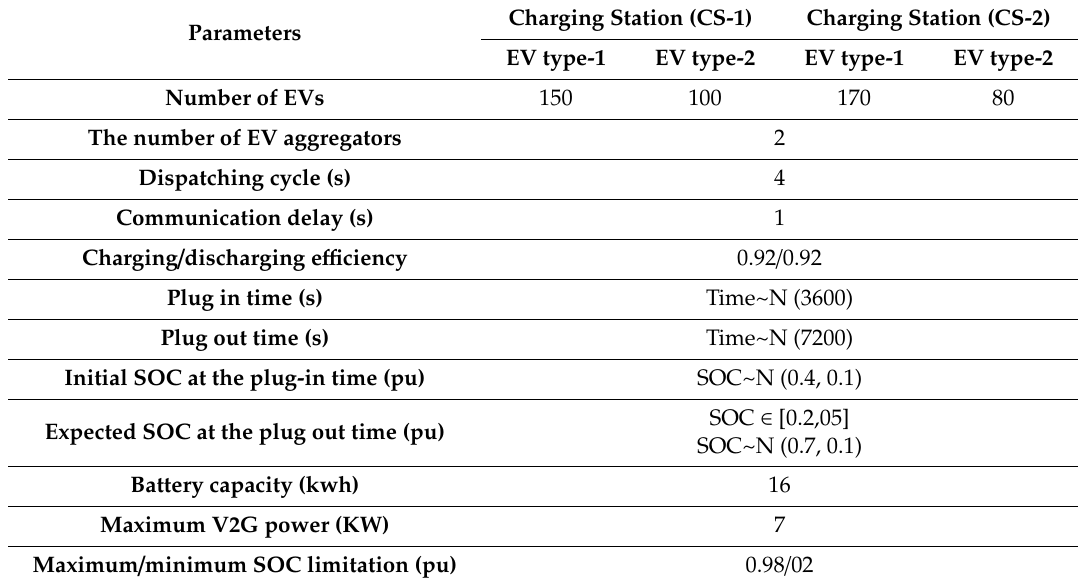
Table 3. Simulation parameters of